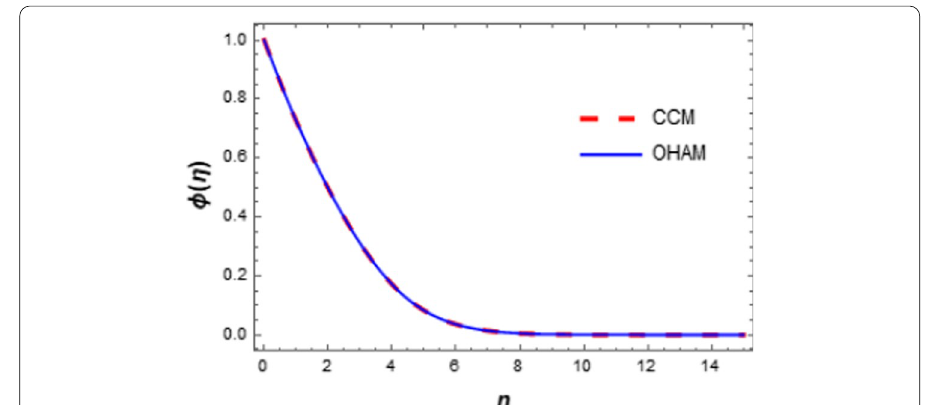
Fig. 5 Comparison of the nanoparticle volume fraction obtained using CCM and OHAM